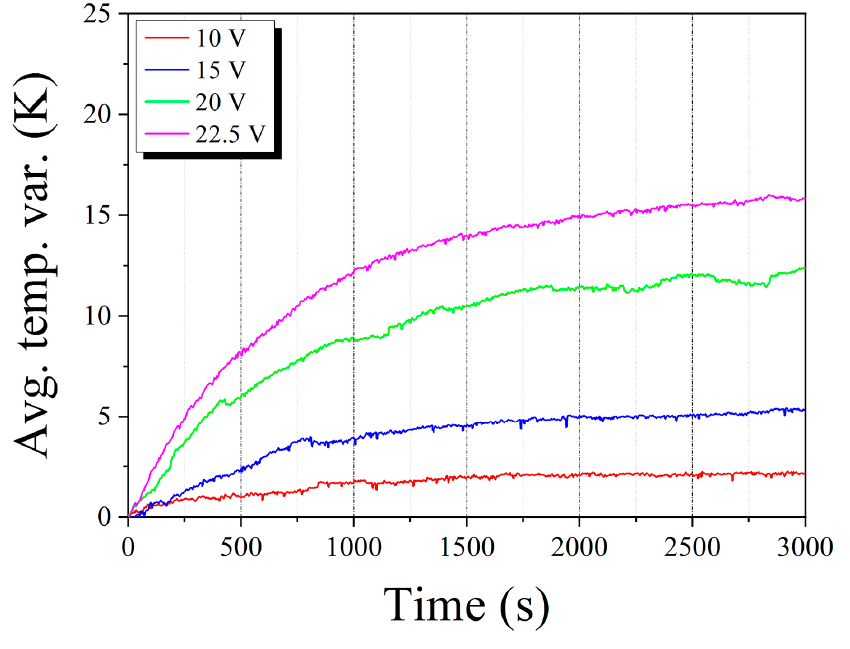
Figure 4. Measured transient profiles of average temperature variations.